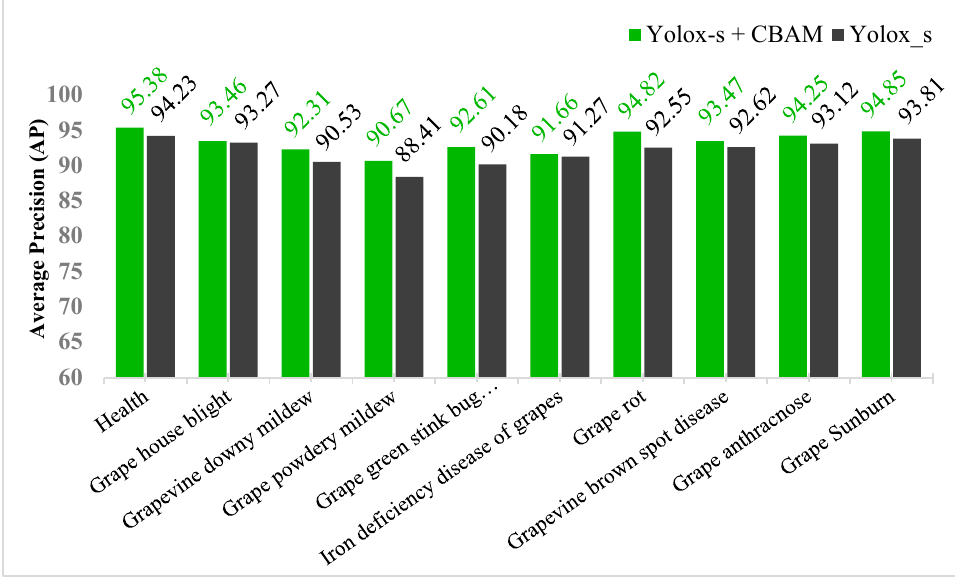
Figure 9. Comparison of the validation results of the optimization model on the overall dataset.